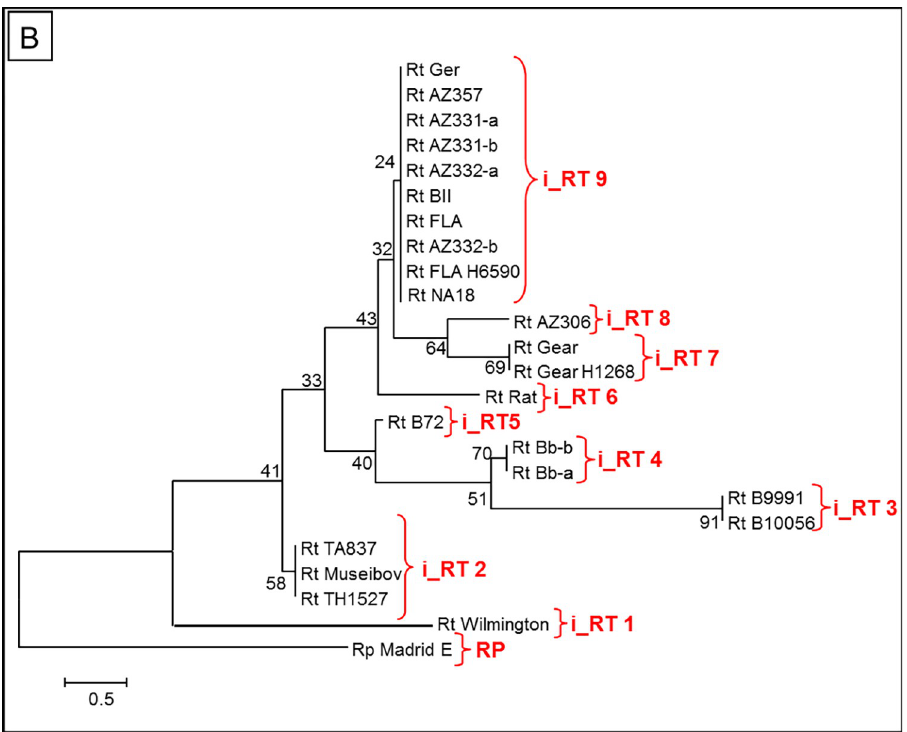
Fig 3. Neighbor joining tree analysis of the variant genetic sites found in isolates of R . typhi . Clades derived from 7 INDEL sites.